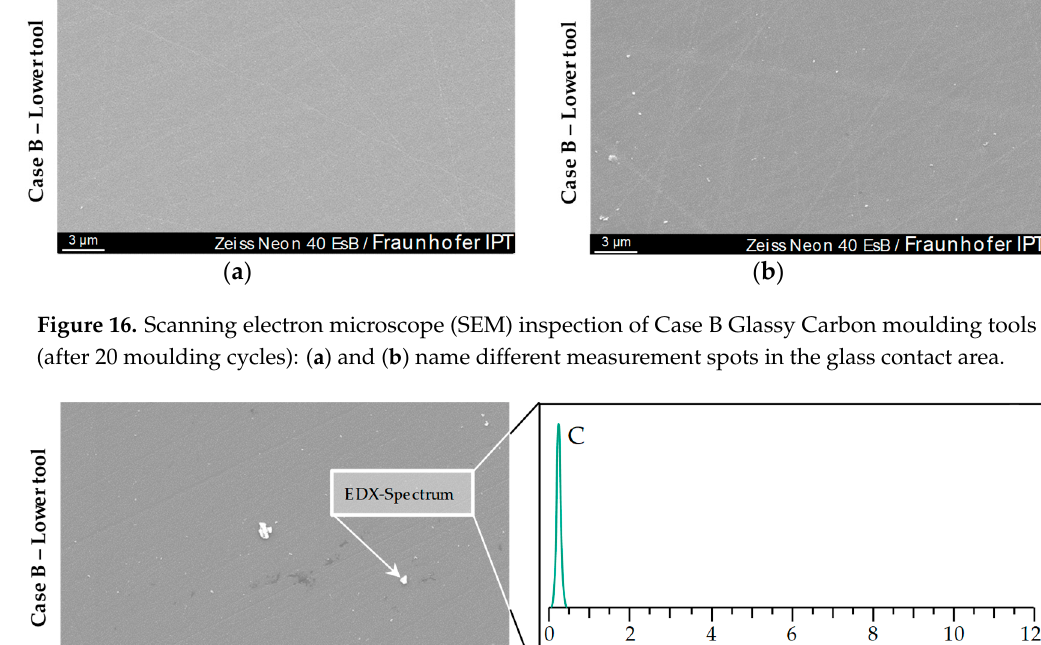
Figure 17. Carbon imperfections on Glassy Carbon surface of Case B tool samples and corresponding EDX measurement.